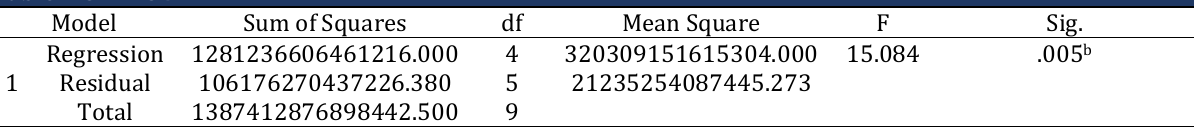
Table 4.8: ANOVA a Model Sum of Squares Mean Square